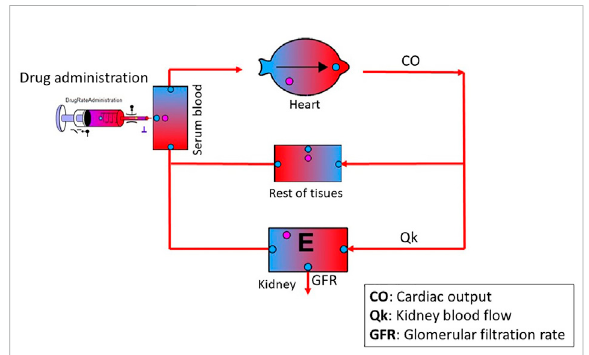
FIGURE 1 Schematic diagram of the minimal PBPK model developed in PhysPK.BlacksolidcirclesareBooleancomponentsforactivation/ deactivation of processes (i.e., dose administration); pink and blue solid circles, are recording components of the system (i.e., drug concentration in a speci fi c region of the system such as plasma, tissue, etc.,). Organ with an E inside means that it has elimination. The purple T next to the syringe means that the administration has a rate and it can be